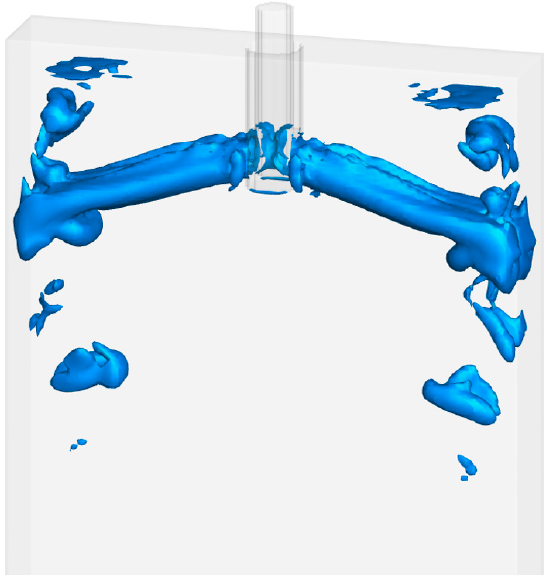
Figure 10. Typical flow of the upper and lower streams near the wall of the mold and corresponding vortex structures using a vorticity w of 10.